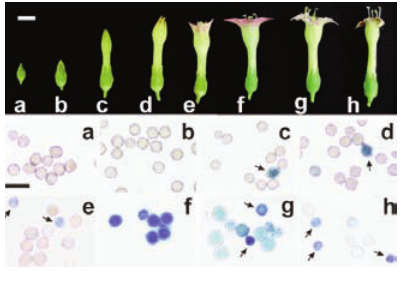
Figure 5. RcDREB1 promoter controlling GUS expression during pollen/microspore grains development in transgenic tobacco plants. At stage a, the anthers and pistil are fully differentiated. Stage b: calyx opens slightly at top of bud; stage c: corolla tube bulges at tip of calyx; stage d: corolla is elongating and petals are green and slight- ly open. Stage e: corolla limb is semi open and stigma and anthers are visible. Stage f: Figure 4. Expression of the RcDREB1 gene flower open and anthers dehisced, and in castor bean pollen grains from male corolla limb is fully expanded and deep flowers 1 and 2 days before anthesis (1, 2), pink. Stages g and h: flower in senescent. during anthesis (3) and 2 days after anthe- Arrows point to dehydrated pollen grains sis (4). The upper bands are consistent in c to h. White bar in the upper panel cor- with the expected fragment amplified from responds to 1 cm and serves as scale for the RcDREB1 gene and the lower band flowers. Black bar corresponds to 50 µm corresponds to transcripts from the RcEF and serves as scale for pollen grains in a to ; internal α gene (elongation factor EF-1 control). α